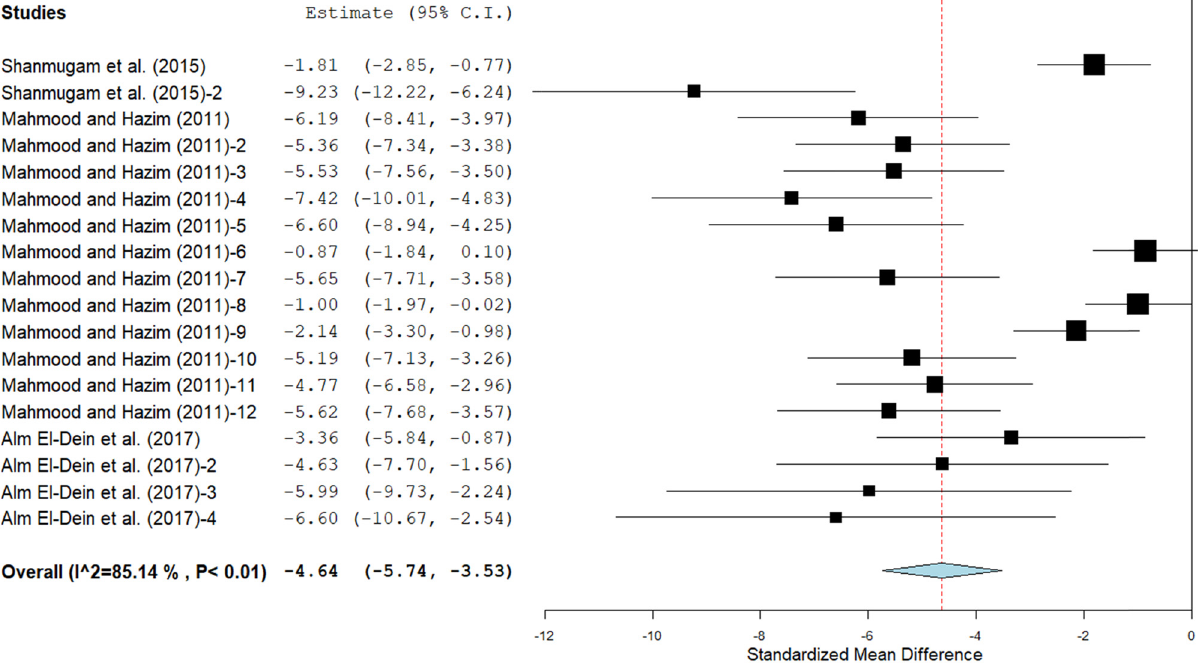
Figure 6: Impact of dietary zinc additive on dead sperm percent. The thick vertical line is the line of no e ff ect ( i.e. SMD = 0 ) . Points to the left of this thick vertical line connote a decrease in dead sperm percent, while points to the right depict an increase in dead sperm percent. The dotted line shows the overall SMD. The result is considered signi fi cant the 95% CI of the overall SMD did not include zero.